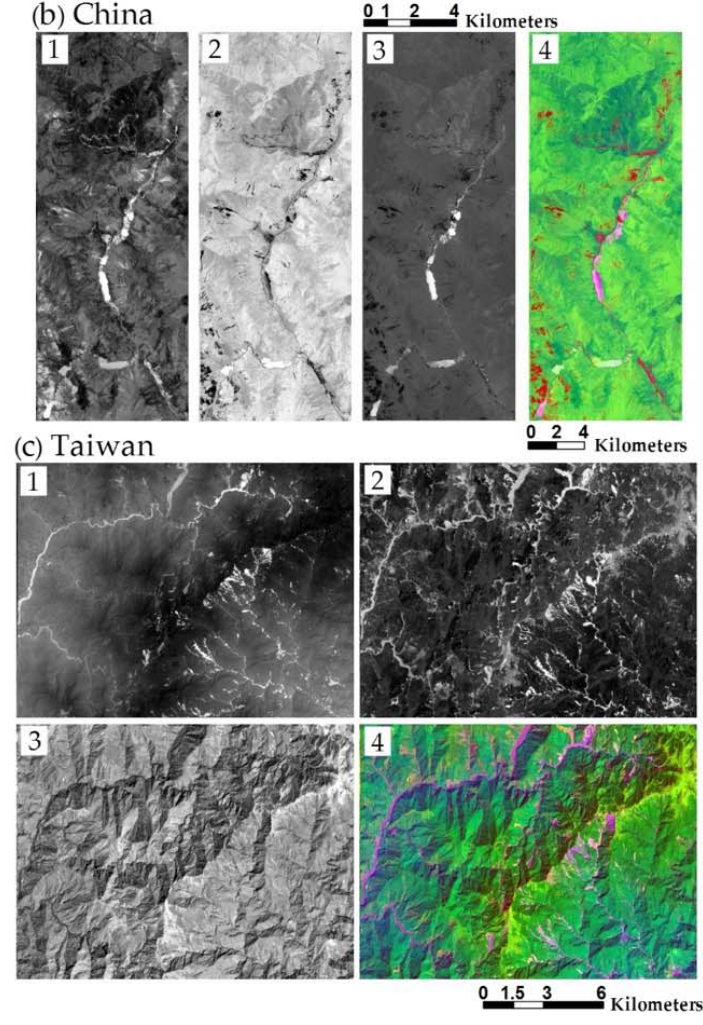
Figure 5. Representation of three MNF features and their corresponding color composite for study areas of ( a ) India, ( b ) China, and ( c ) Taiwan. The numbers 1, 2, and 3 show the MNF features and number 4 indicates their color composite. The order of composition is in red (1), green (2), and blue (3).